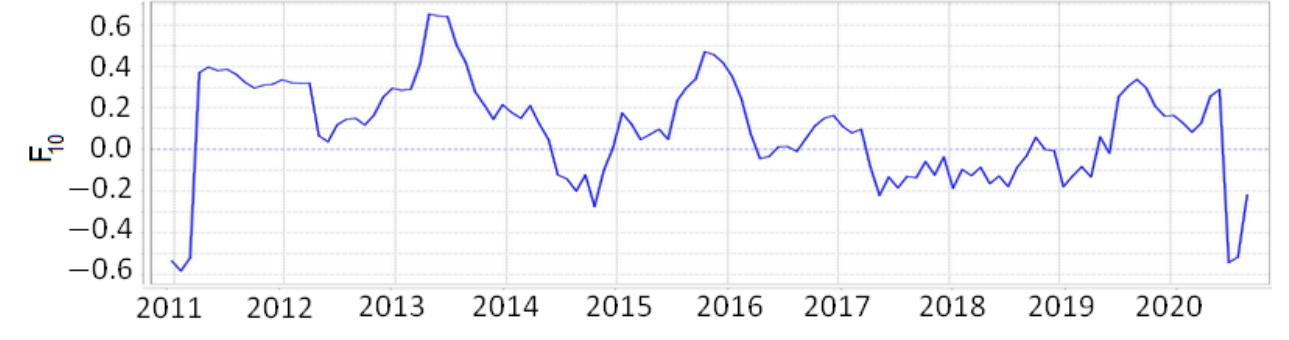
Figure 14. Japan. The time series of field F 10 at point 35.45 ◦ N and 139.2 ◦ .